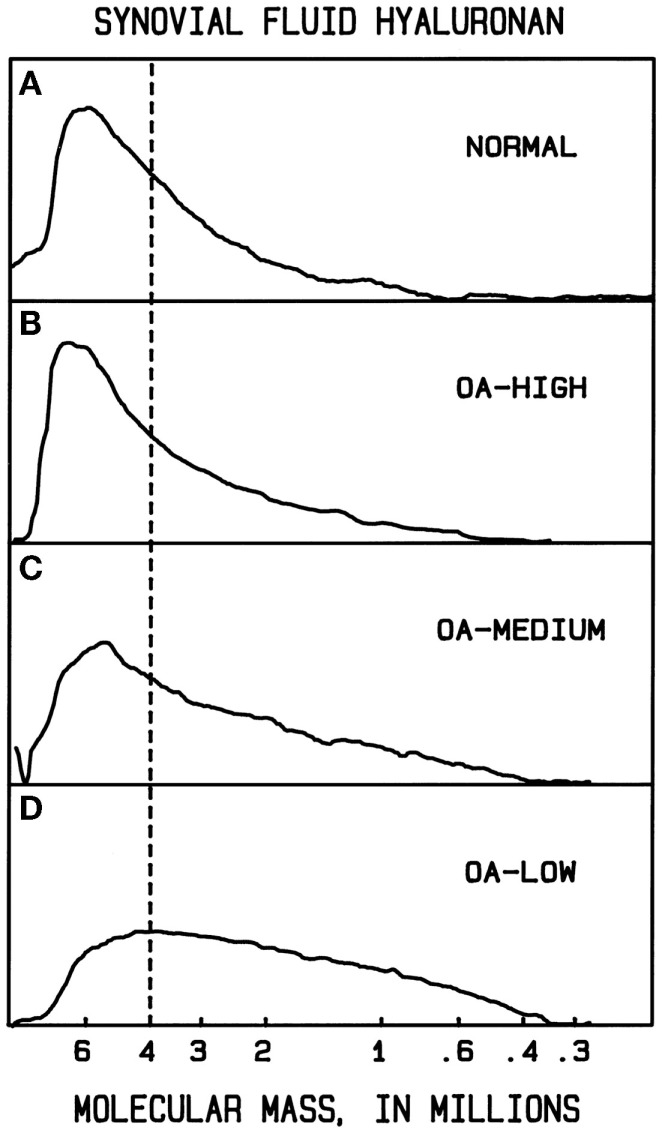
Example molecular mass distributions of human synovial fluid (SF) HA determined by agarose gel electrophoresis. From top to bottom: (A) normal human SF obtained from young healthy volunteers. (B–D) Representative osteoarthritis (OA) patient SF. The dashed vertical line corresponds to the migration position of 4000 kDa HA. The fraction of HA having slower electrophoretic migration, and thus higher M than 4000 kDa, is a measure of the high M HA content. In normal human SF, the portion of HA with M > 4000 kDa averaged 61%. OA patients varied in the extent of HA degradation. The OA-HIGH profile, similar to that seen in normal SF and representative of OA samples with more than 60% of HA having M > 4000 kDa, was found for 26% of patients. The OA-MEDIUM profile, representative of OA samples with approximately 41–60% of HA having M > 4000 kDa, was found for 41% of patients. The OA-LOW profile, representative of OA samples with <40% of HA having M > 4000 kDa, was found for 33% of patients. From Lee (90).